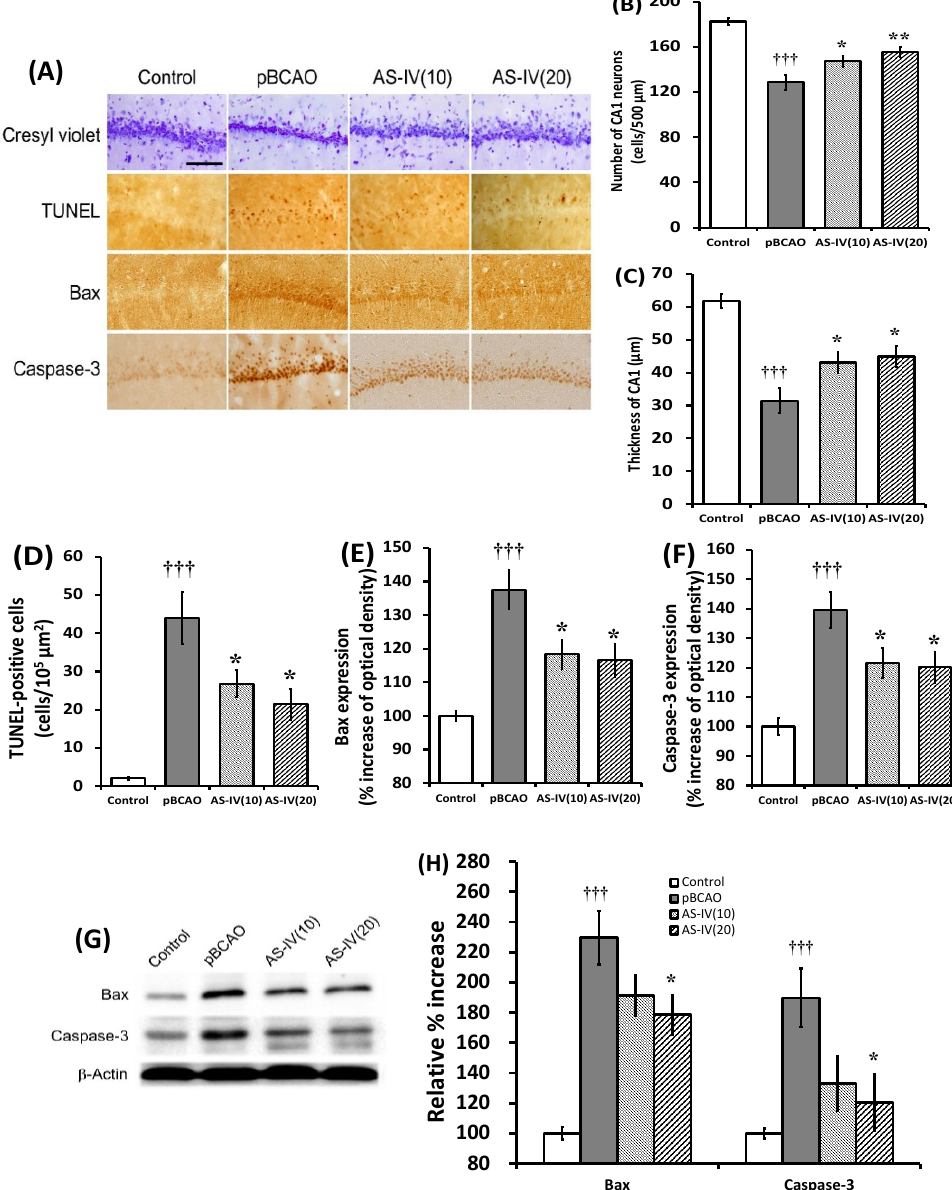
Figure 4. Effects of astragaloside IV (AS-IV) on neuronal apoptosis in the hippocampus. Representative photographs show the CA1 of the hippocampus stained with cresyl violet, TUNEL, Bax and caspase-3 expression ( A ). Scale bar is 50 µm, applicable to all sections. AS-IV, at both 10 and 20 mg/kg dose, significantly attenuated the neuronal loss and thinned thickness of the CA1 ( B , C ). AS-IV also significantly reduced TUNEL-positive cells ( D ) and significantly attenuated the upregulation of Bax ( E ) and caspase-3 ( F ) in the CA1 of the hippocampus at both 10 and 20 mg/kg treatment. Representative western blots illustrating differences in the bands of Bax and caspase-3 ( G ). The upregulation of Bax and caspase-3 protein expression was significantly attenuated by AS-IV at 20 mg/kg dose ( H ). Data are presented as mean ± SEM ( n = 6 in each group; ††† , p < 0.001 between the control and the pBCAO groups; * , p < 0.05; ** , p < 0.01 between the pBCAO and AS-IV